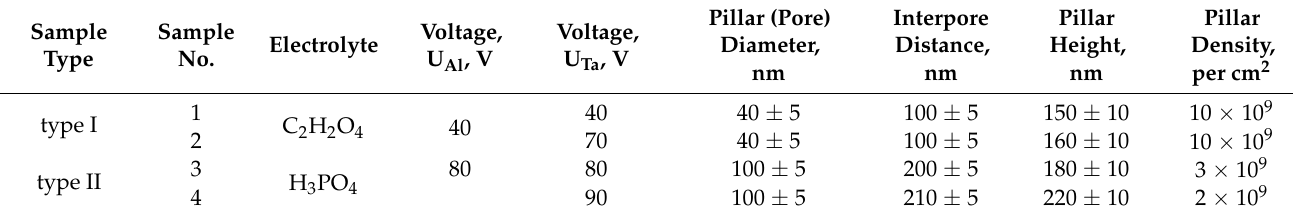
Table 2. Parameters of the TPAA samples and their preparation